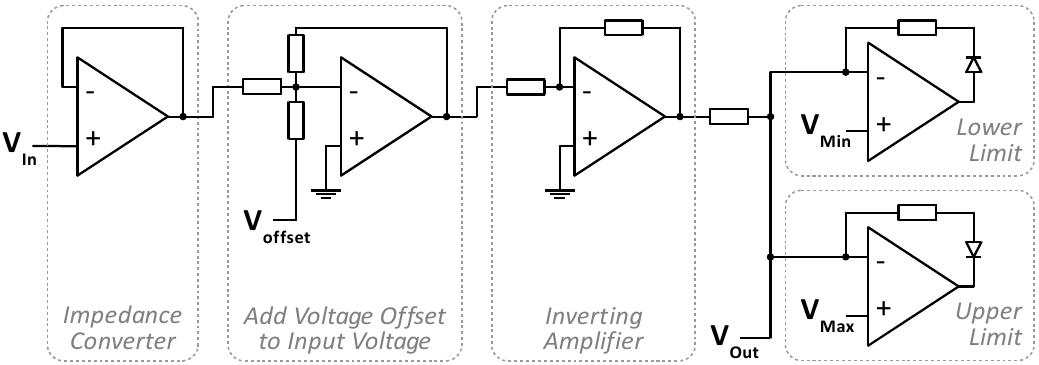
Figure 8. Electric circuit for transforming the low impedance input signal to high impedance signal, shifted by 0.5 V and limited to a 0–1 V ADC measurement range.